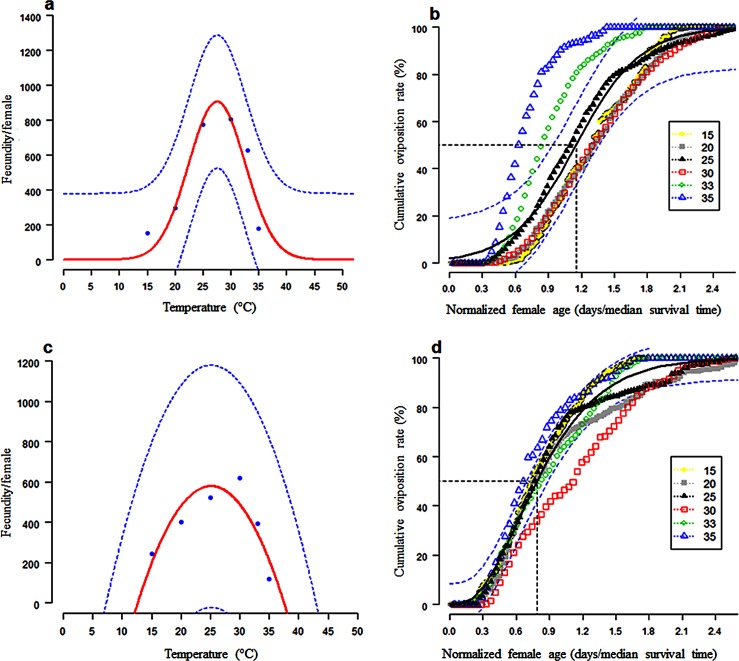
Temperature-dependent total egg production curve for C. rosa (fitted function: Polynonmial model) and C. quilicii (fitted function: Guassian denomination function) (2a and 2c, respectively). Age-related oviposition rate for C. rosa (2b; fitted curve: Second-order polynomial function) and C. quilicii (2d; fitted curve: Gamma distribution function). The dots are observed data points at each of the test temperatures. The upper and lower 95% confidence intervals of the models are indicated. Age of the females at 50% oviposition is indicated.